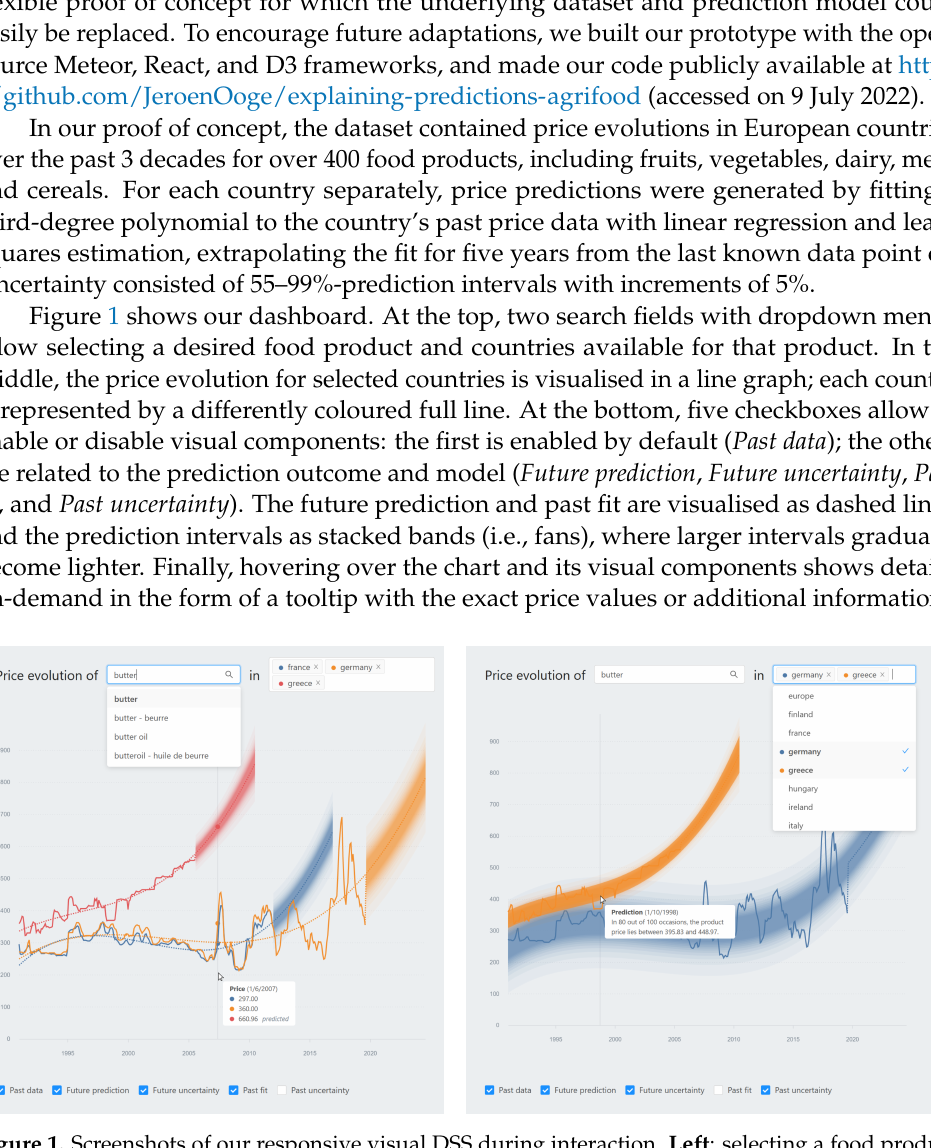
Figure 1. Screenshots of our responsive visual DSS during interaction. Left : selecting a food product in the upper left search field and getting details about the price and date upon hovering over the line chart. Right : selecting countries in the upper right search field and getting a description of the hovered fan ( “In 80 out of 100 occasions, the product price lies between A and B” . where A and B are the lower and upper bounds of the prediction interval at the indicated date,